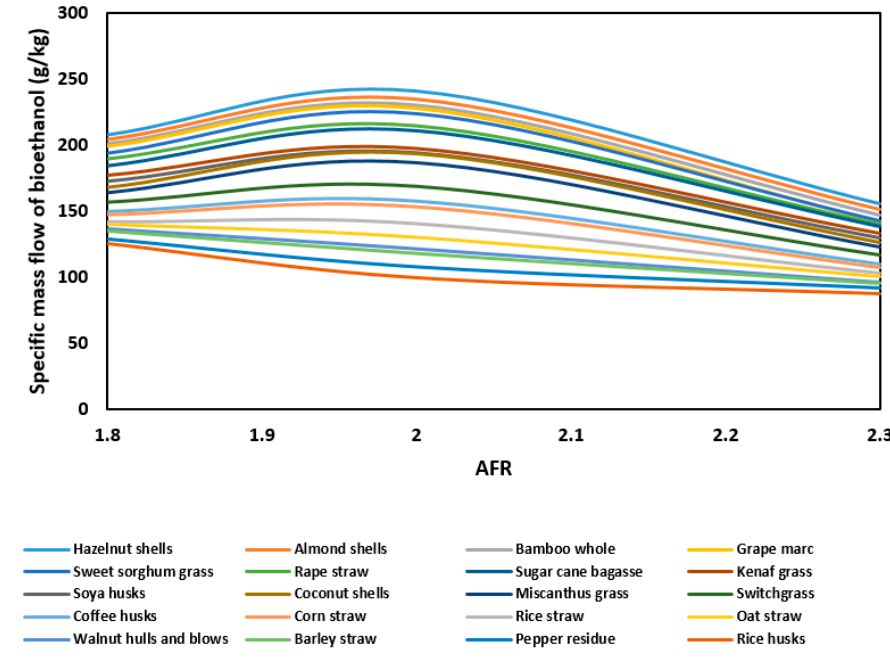
Figure 5. Effect of the air-to-fuel ratio on ethanol sm for 20